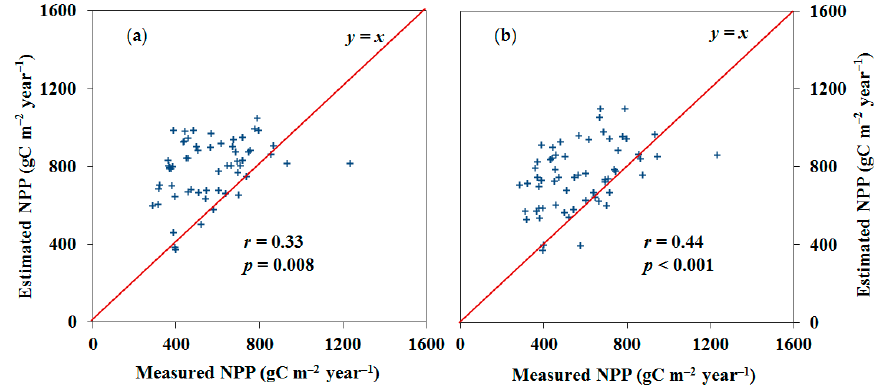
Figure 12. Validation of the NPP_GIMMS3g and NPP_like data using the field-measured data ( N = 59). The two scatter plots are the NPP results based on: ( a ) the original GIMMS3g NDVI; and ( b ) the normalized MODIS-like NDVI.